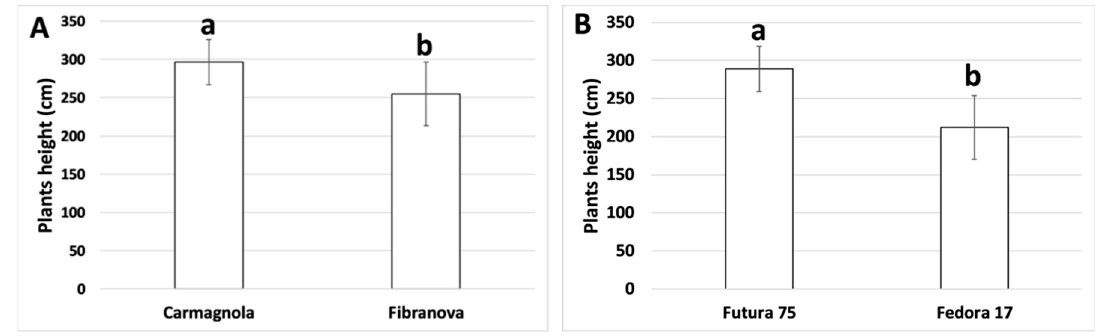
Figure 1. Plant heights of fiber ( A ) and seed ( B ) varieties at harvest time. Different letters indicate